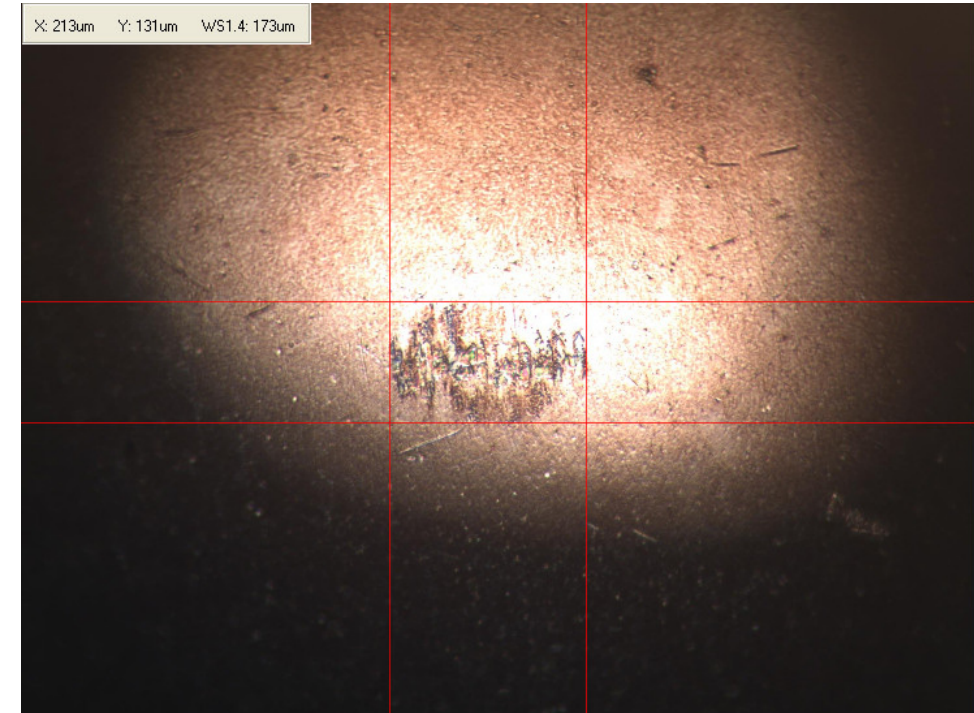
Figure A9. SAE 40—99% m/m; DO—1% m/m.